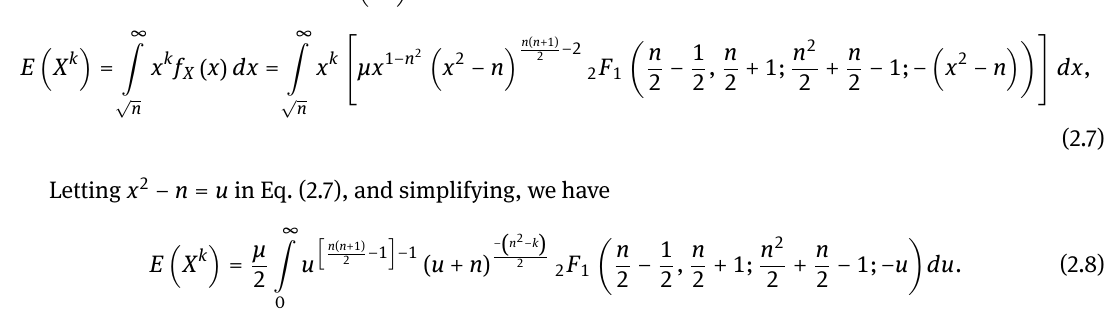
√ 2 ≤ x ≤ 1000 (cid:16) (cid:17) X k , when 0 < k < 1 or k < 0. We